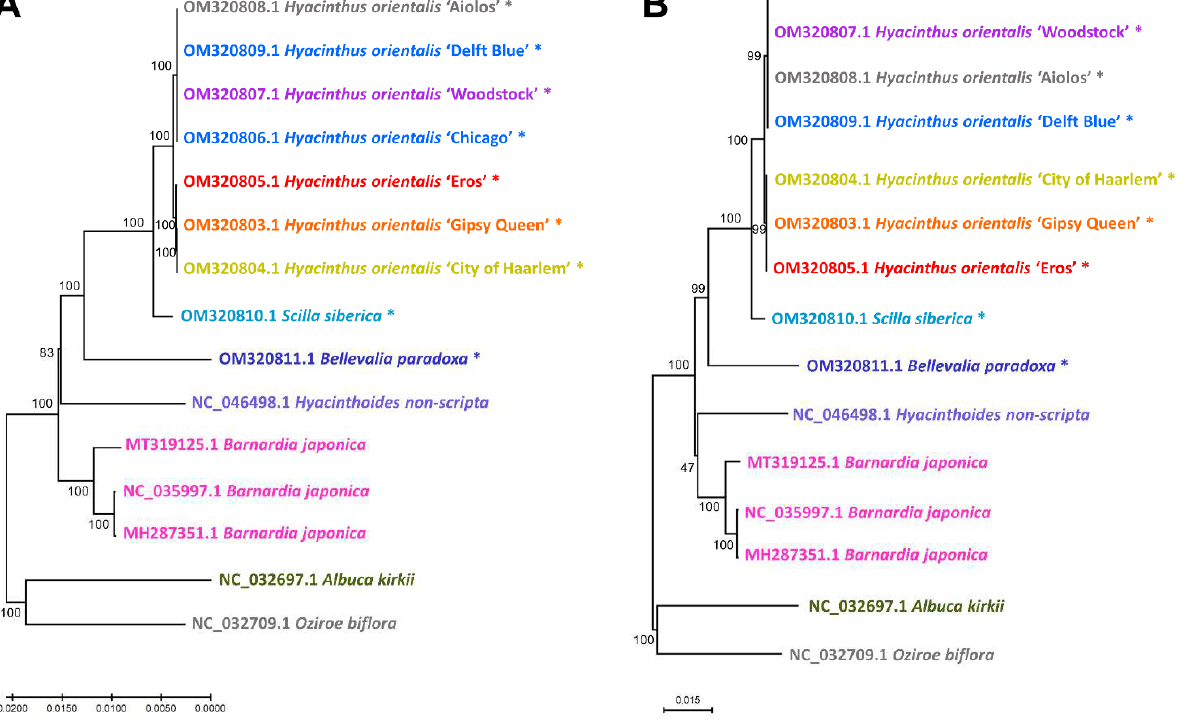
Figure 10. Maximum Likelihood (ML) trees based on the fifteen Scilloideae chloroplast genomes. ( A ) ML tree constructed based on the full alignment of complete chloroplast genomes. One unit in scale bar = 0.005. ( B ) ML tree constructed based on the extracted loci with Pi over 0.035 ( trnK-UUU- trnQ-UUG , trnS-GCU-trnG-UCC , petN-psbM , psbC , psbE-petL , ndhA , trnN-GUU-trnR-ACG , rrn23 and trnA-UGC ). The numbers next to branch nodes are the bootstrap values. Asterisked accessions were achieved in this study. One unit in scale bar = 0.015. The accession numbers and species names were coloured according to flower colours (white is presented as grey instead).